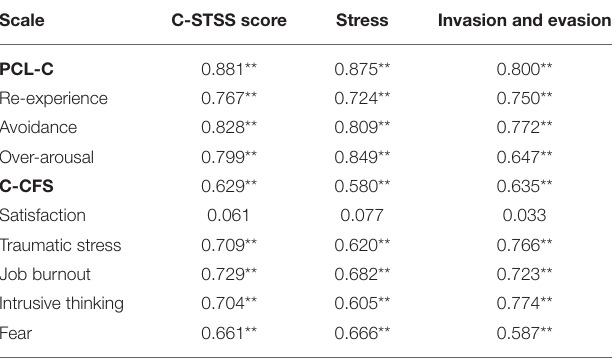
TABLE 4 | Correlation between C-STSS score and criteria [r, ( n = 218)].